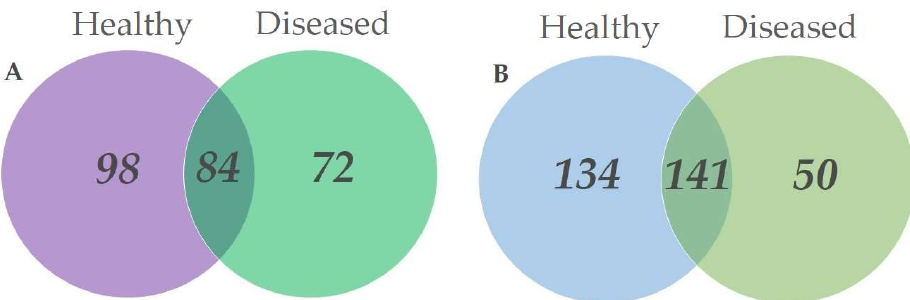
Figure 3. Venn diagrams showing the diversity and overlap of fungal taxa in different substrates collected in Ulmus glabra stands. ( A ) roots from healthy-looking and diseased trees; ( B ) leaves from healthy-looking and diseased trees.